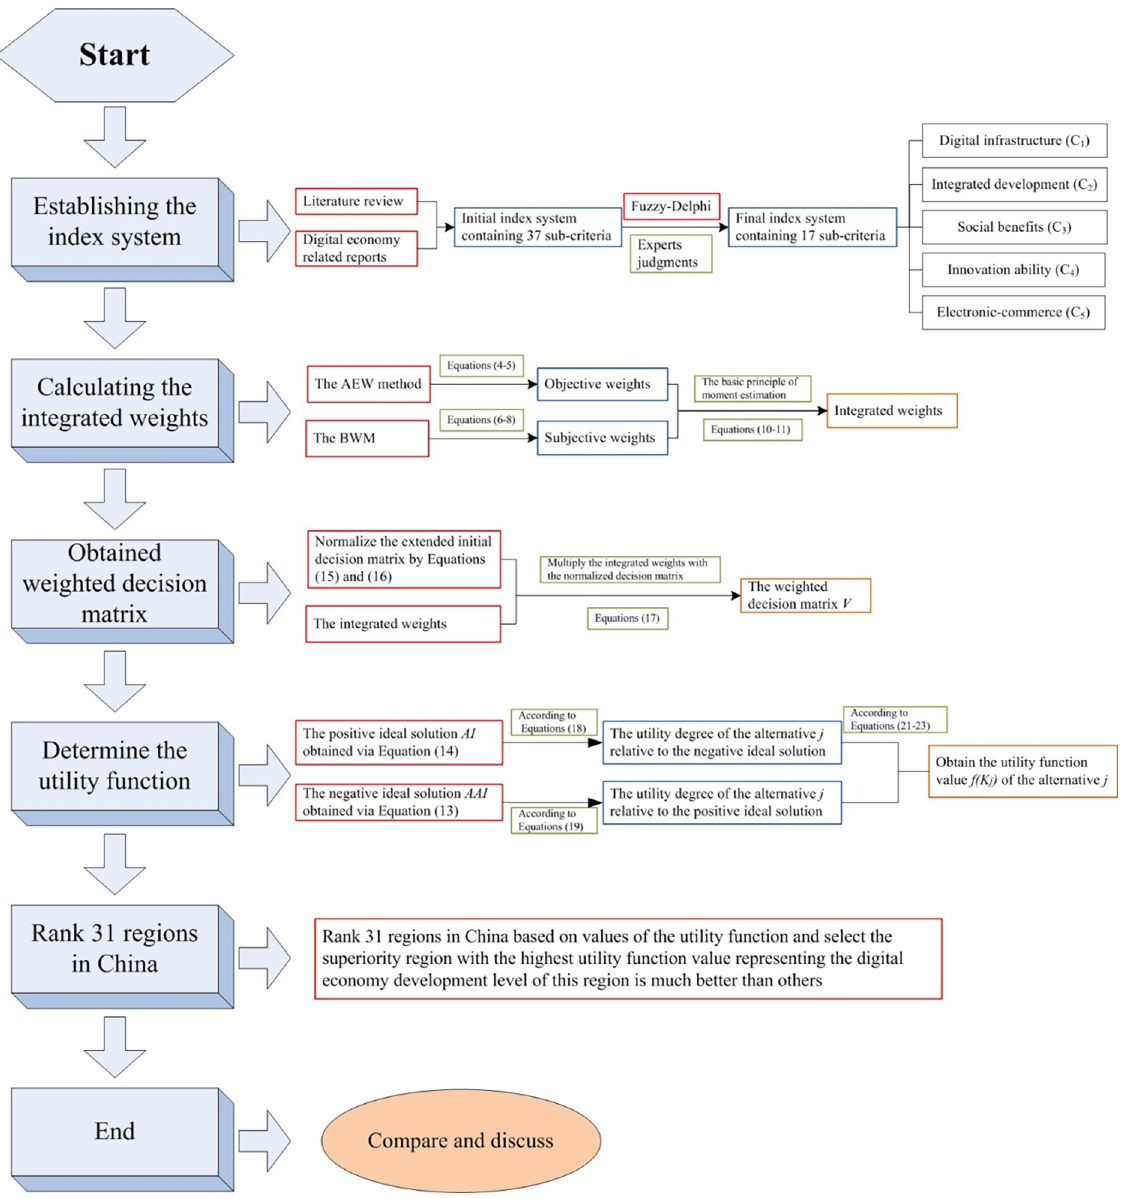
Fig 1. The concrete procedure of the hybrid MCDM model for comprehensive evaluation of DE development.